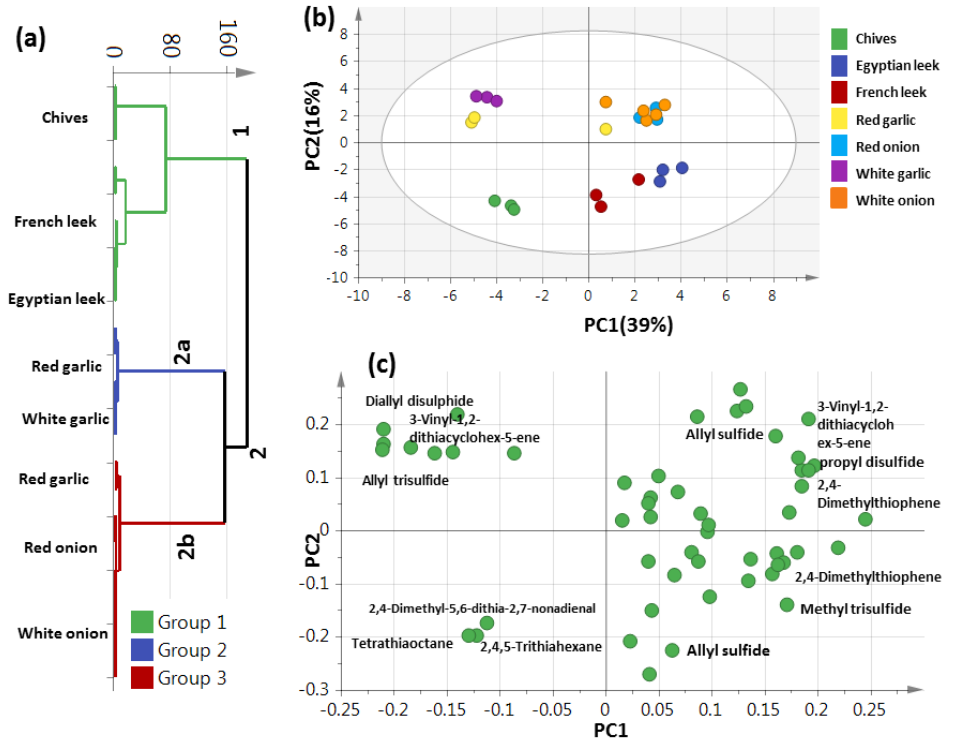
Figure 5. Unsupervised multivariate data analyses of the studied Allium species derived from the modeling of sulfur metabolites analyzed via GC-MS (n = 3). ( a ) HCA plot. ( b ) PCA score plot of PC1 vs. PC2 scores. ( c ) The respective loading plot for PC1 and PC2, providing mass peaks and their assignments. The metabolome clusters are placed in two-dimensional space at the distinct locations defined by two vectors of principal component PC1 = 39% and PC2 = 16%.